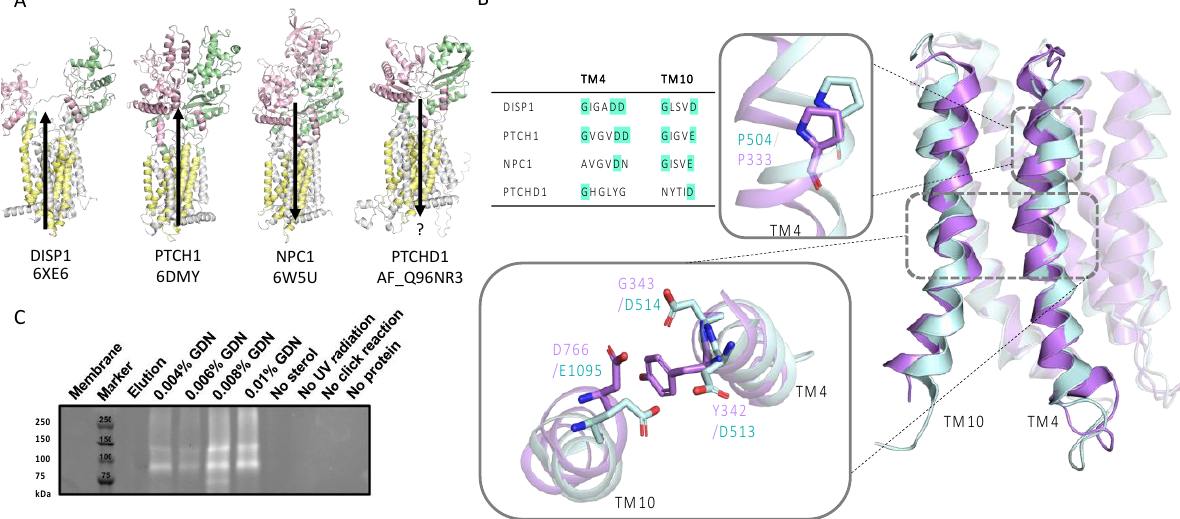
Figure 4. PTCHD1 cholesterol binding. ( A ) Patched domain-like family cholesterol transporters contain an SSD (yellow) and two ECDs (pink and green). Direction of cholesterol transport with respect to the concentration gradient is indicated with black arrows. The direction in which PTCHD1 transports cholesterol has not been experimentally verified (indicated with “?” under the arrow). ( B ) A sequence alignment of cholesterol transporters showing DISP1 and PTCH1 have conserved RND motifs. NPC1 only has one conserved motif, while PTCHD1 has neither. Structural alignment of PTCHD1 (purple) and PTCH1 (blue) SSDs demonstrates high structural similarity. The top inset shows SSDs shows a conserved, functionally critical, proline on TM4. The bottom inset shows the charge neutralising residues at the TM4:TM10 interface of PTCH1 and corresponding residues of PTCHD1. ( C ) SDS-PAGE of PhotoClick cholesterol assay. Clear bands are visible in each lane of PTCHD1 with GDN around the estimated 130 and 100 kDa molecular weight of glycosylated and unglycosylated PTCHD1, but not in control sample lanes.